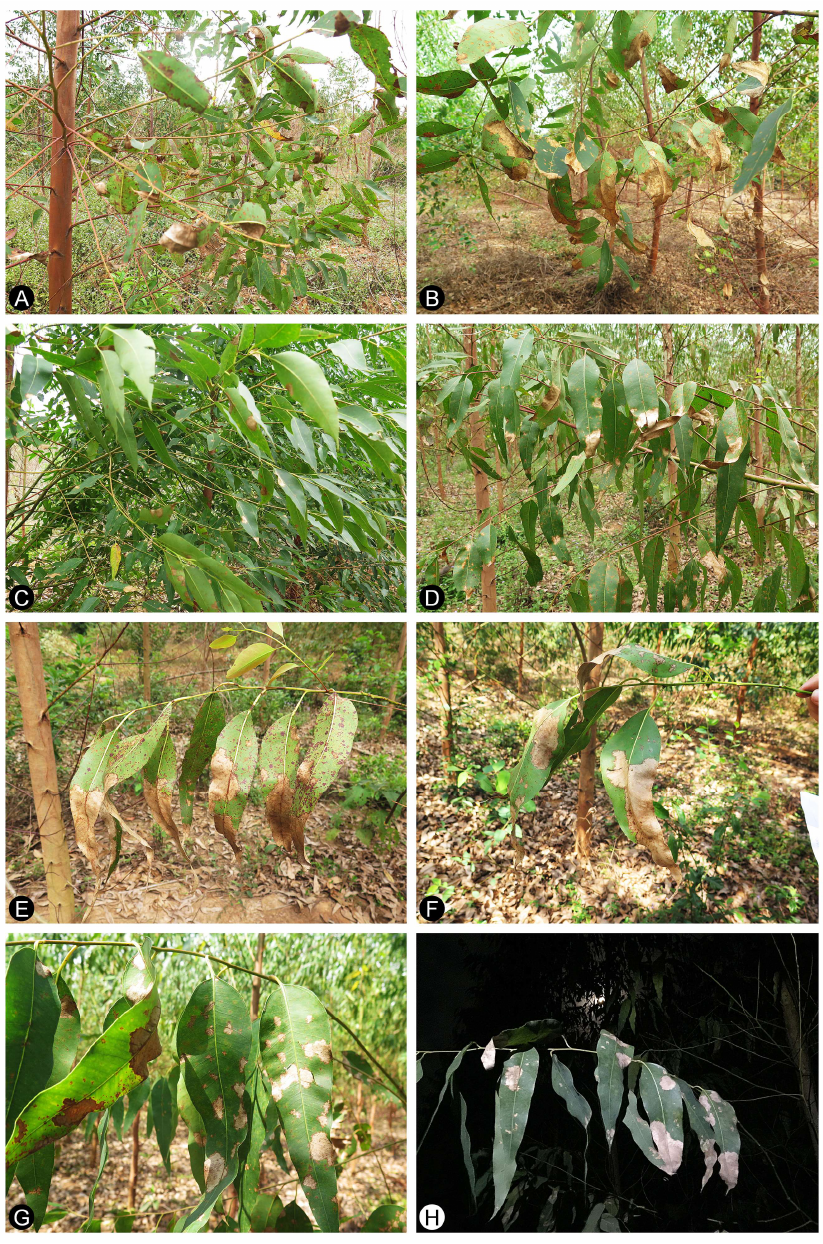
Figure 1. Disease symptoms on multiple Eucalyptus genotypes in one experimental plantation caused by species of Calonectria . ( A – C ): Leaf spot in three E. urophylla × E. grandis hybrid genotypes CEPT1863 ( A ), CEPT1861 ( B ), and CEPT1862 ( C ), the infected leaves of CEPT1861 and CEPT1862 became blighted and dried; ( D – H ): Leaf spot and blight in three E. urophylla × E. tereticornis hybrid genotypes, CEPT1866 ( D , E ), CEPT1868 ( F ), and CEPT1869 ( G , H